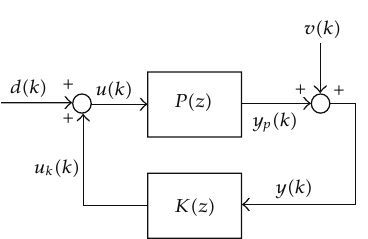
Figure 1: Closed-loop system with the true plant P (cid:4) z (cid:5) and the model-based controller K (cid:4) z (cid:5)